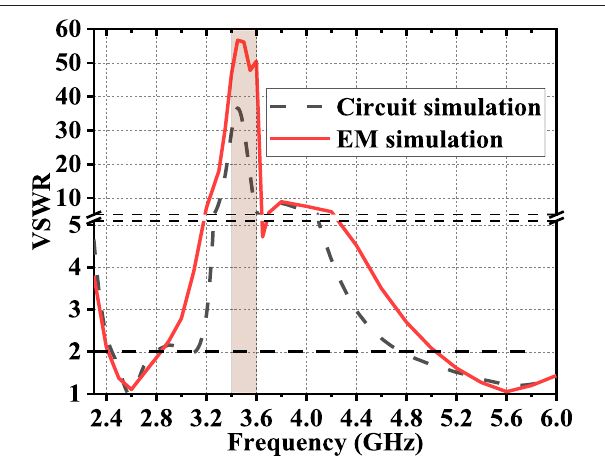
FIGURE 9 | Circuit simulation result of the equivalent circuit, and EM simulation result of the proposed band-notched antenna.